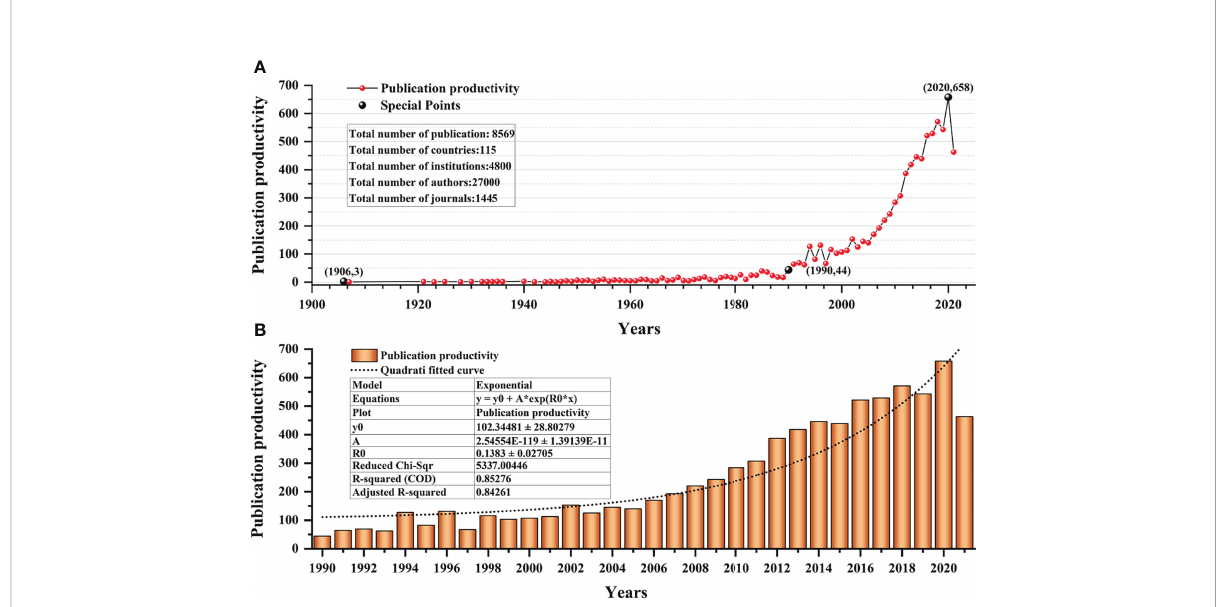
FIGURE 3 The publication volume and cited frequency on the topic of lymphedema. (A) The publication volume of lymphedema from 1900 to 2021. (B) The publication volume of lymphedema from 1990 to